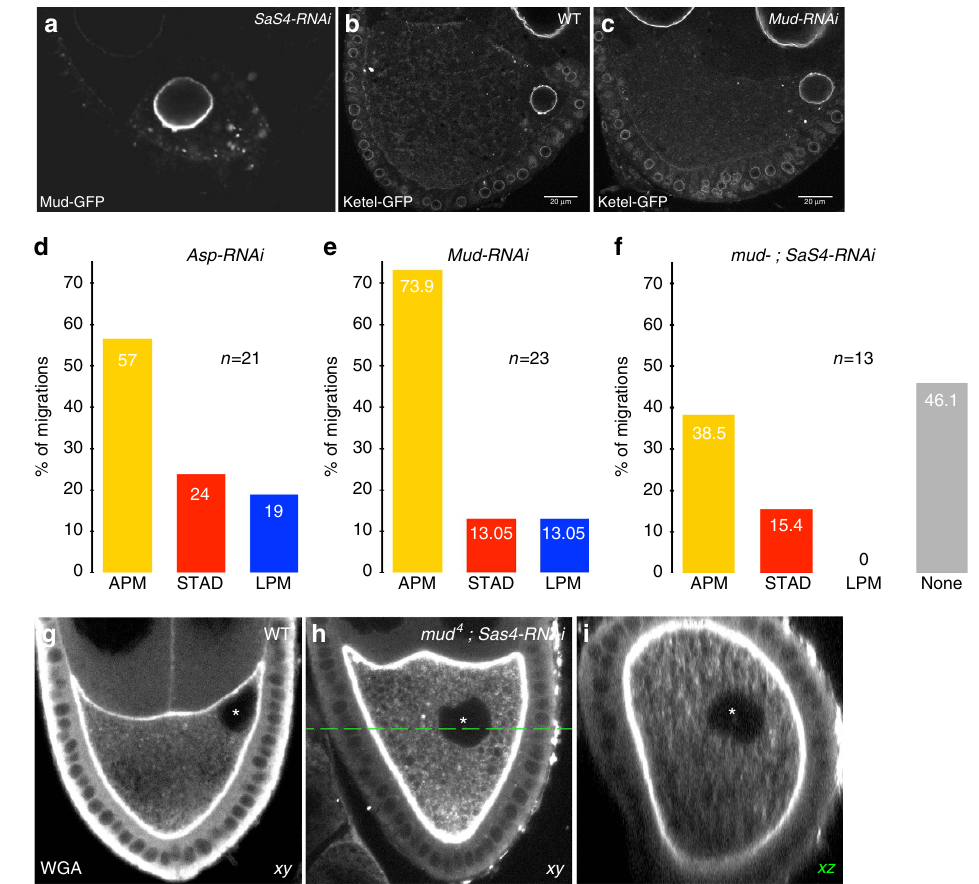
Figure 7 | Mud and the centrosomes fulfil complementary functions in nuclear migration. ( a ) Mud-GFP distribution is unaffected in stage 6 Sas4- depleted oocytes. ( b , c ) Antero-dorsal position of the nucleus revealed by Fs(2)Ket-GFP, in stage 9 wild-type ( b ) or mud -depleted ( c ) oocytes. ( d ) Percentages of the various migration paths taken by nuclei in Asp -RNAi oocytes ( n ¼ 21 independent nuclear migrations). ( e ) Percentages of the various migration paths taken by nuclei in Mud -RNAi oocytes ( n ¼ 23 independent nuclear migrations). ( f ) Percentages of the various migration paths taken by nuclei in mud4, Sas4-RNAi mutant oocytes ( n ¼ 13 independent nuclear migrations). Migration is abolished in 46% of the cases. ( g – i ) Stage 9 oocytes stained with WGA highlighting membranes. The nucleus is visualized by an absence of staining and marked with an asterisk. ( g ) wild type ( h ) mud (ref. 4) ; Sas4sRNAi . The green dashed line indicates the xz section displayed in i which illustrates the total lack of nuclear contact with any plasma membrane. WGA, wheat germ